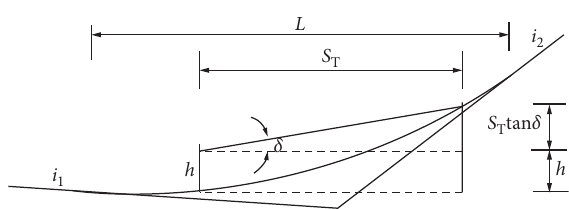
Figure 8: Vehicle headlight irradiation distance ( L ≥ S